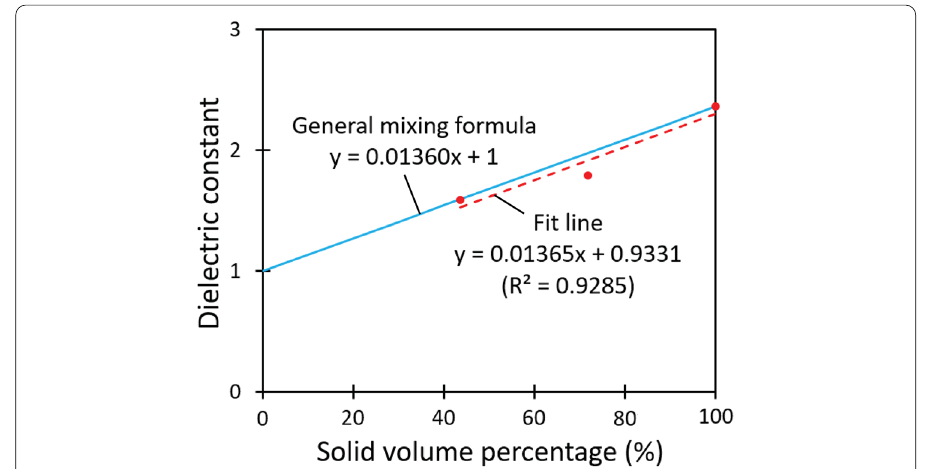
Fig. 6 Measured dielectric constant of the TPU substrate (dots) and its linear fit line (dashed line) showing reasonable agreement to the general mixing formula (solid line)